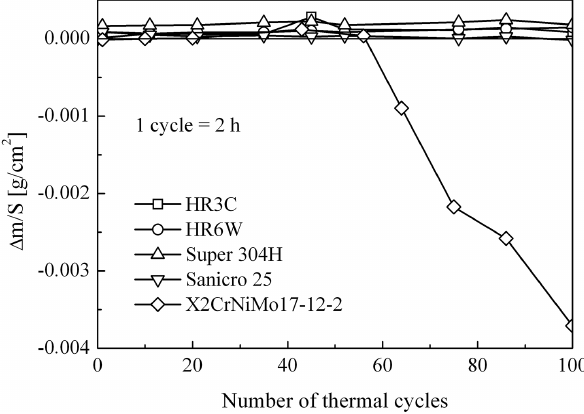
Figure 2: The results of thermal shocks of all materials under investigation ( Δ m/S – mass changes of the oxidized samples per unit surface